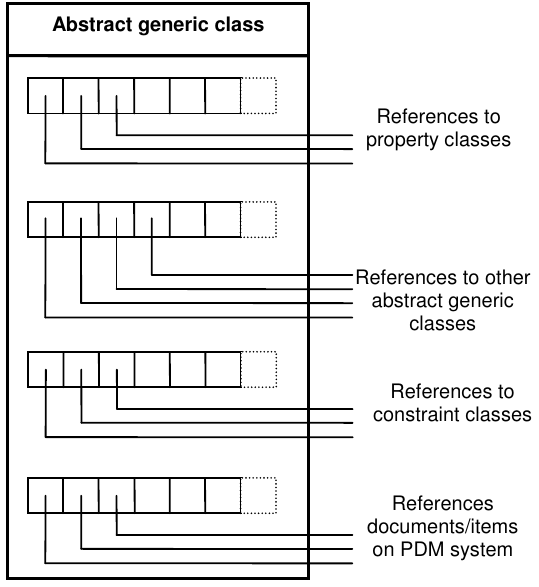
Fig 1. Structure of the abstract generic class